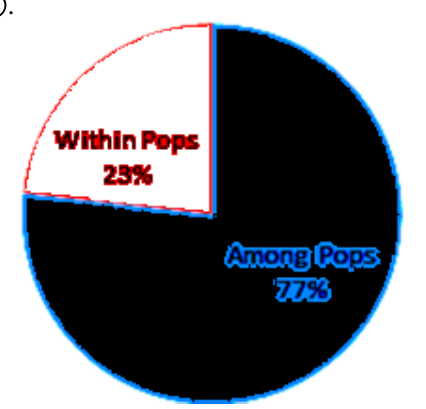
Fig. 5. Molecular variance percent of collected wild violet inter and